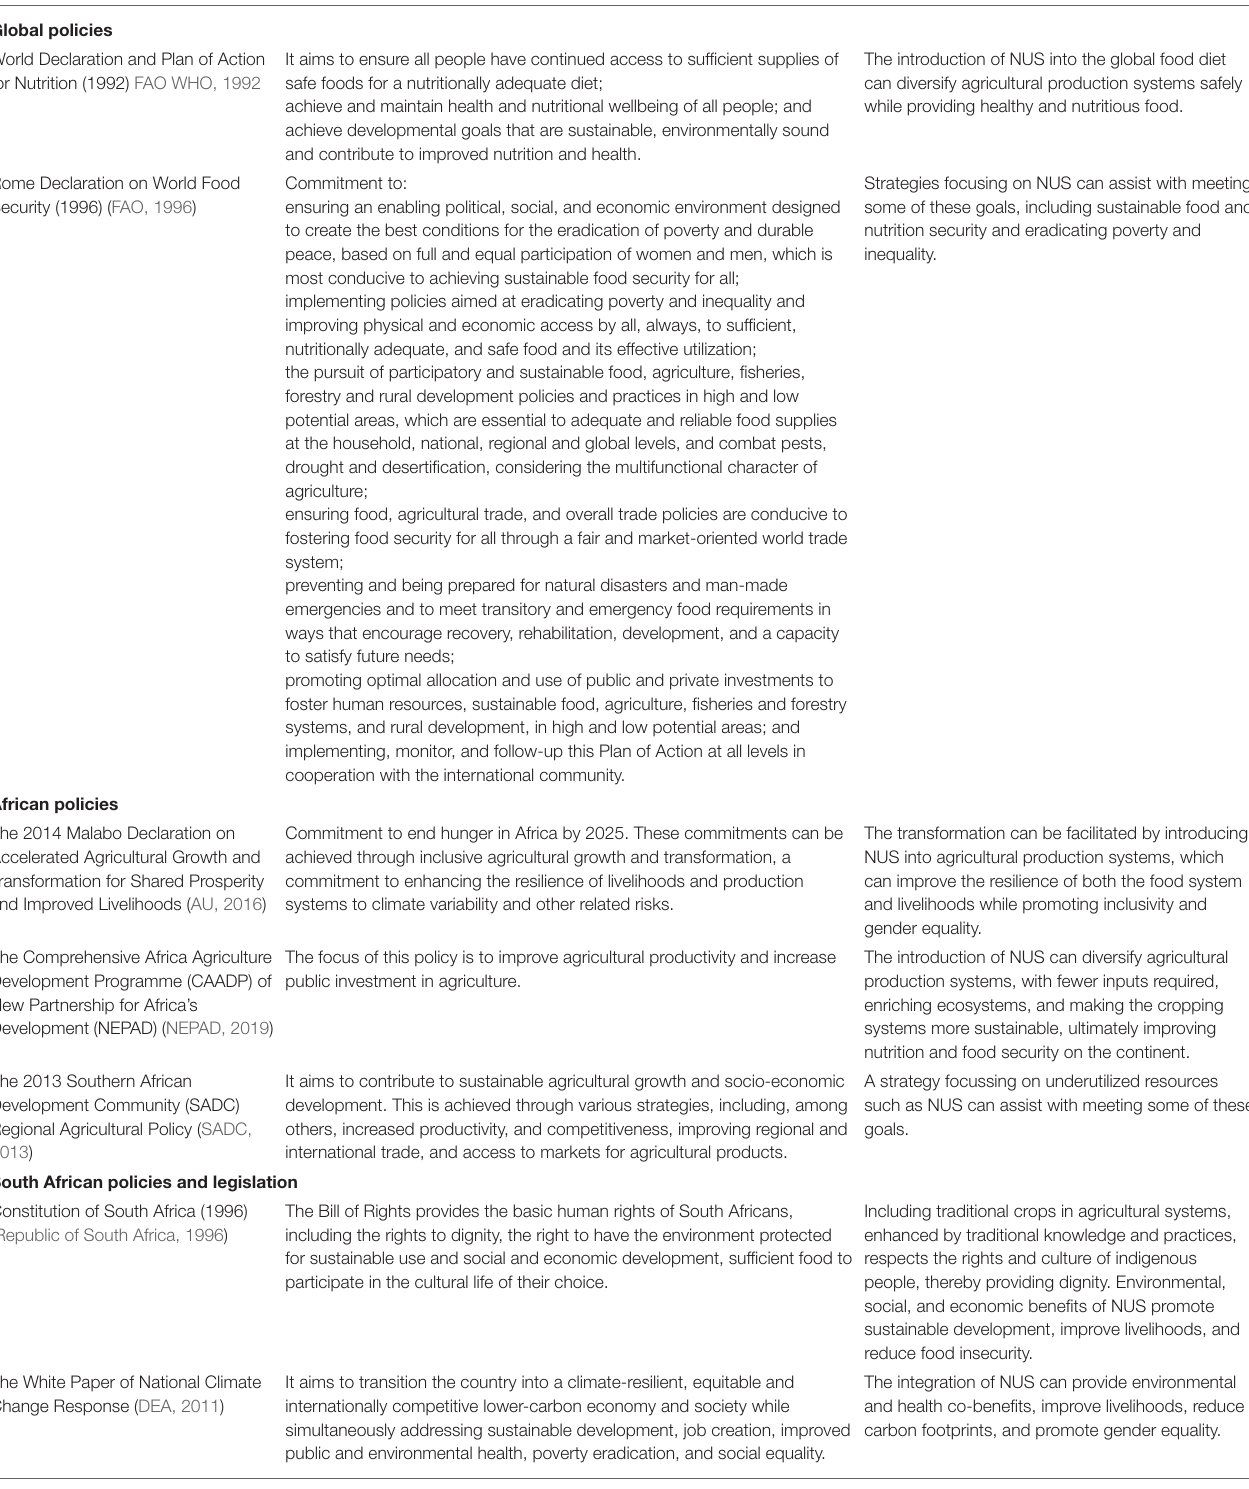
TABLE 2 | Policy implications of NUS research and contribution to the fulfillment of global, African, regional (southern Africa), and national (South Africa)